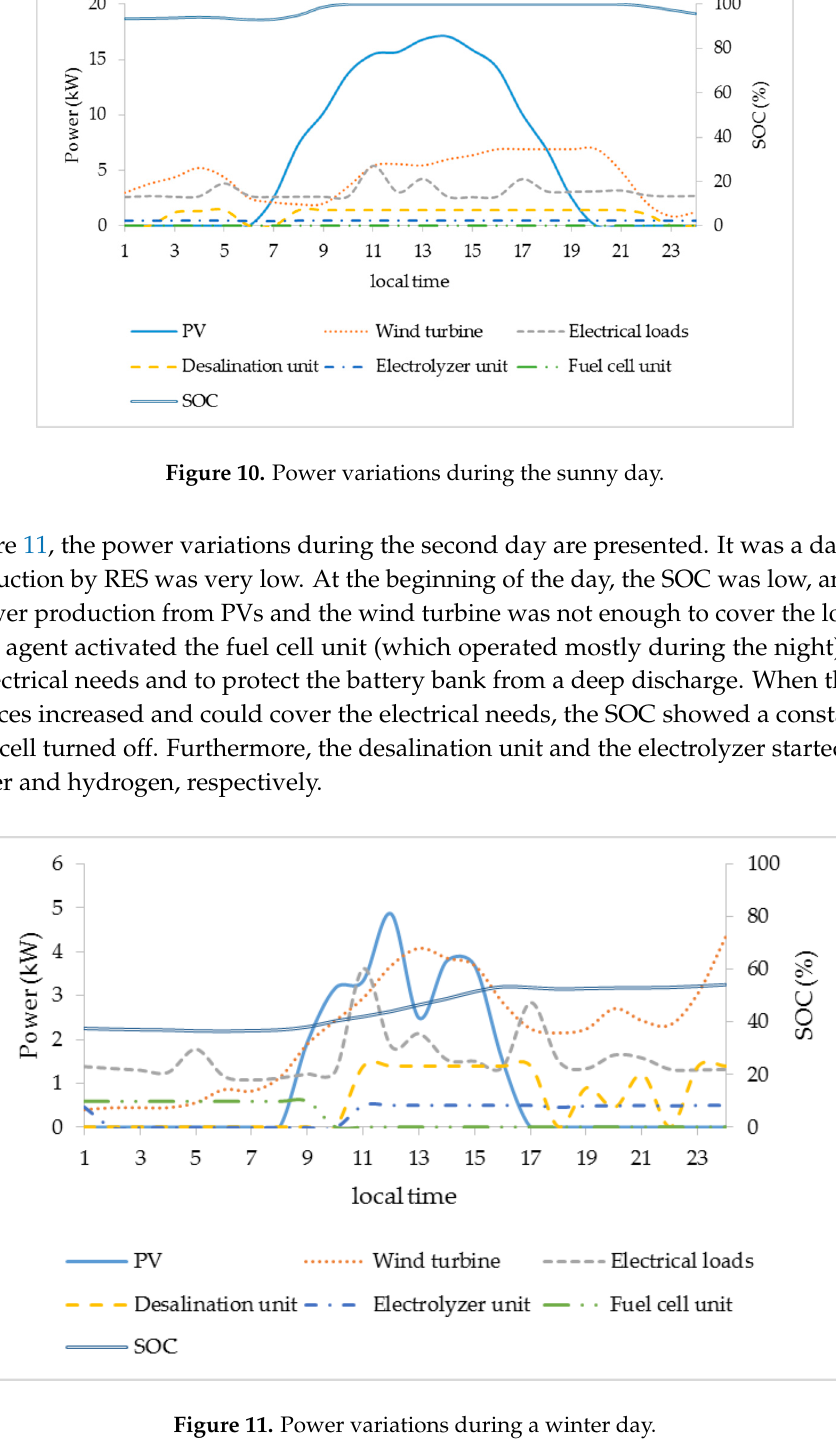
Figure 11. Power variations during a winter